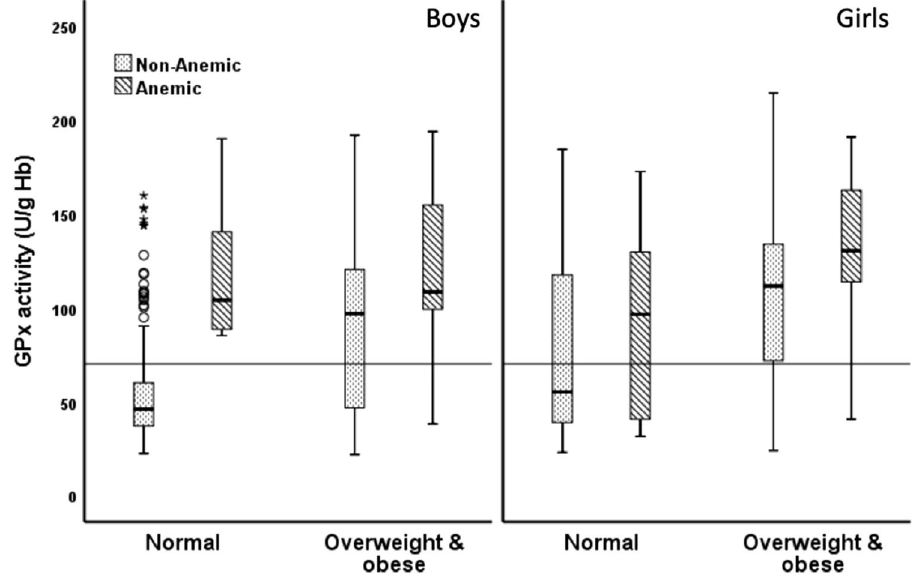
Figure 3. Glutathione peroxidase (GPx) activity in relation to the anemia status. The horizontal line indicates the overall median.